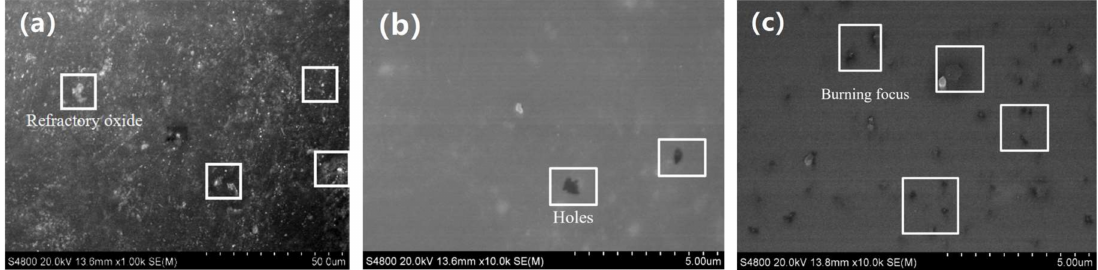
Figure 4. Scanning electron microscope (SEM) micro-morphologies of the enamel coating sintered at different temperature for 5 min. ( a ) is 700 ◦ C, ( b ) is 730 ◦ C, and ( c ) is 760 ◦